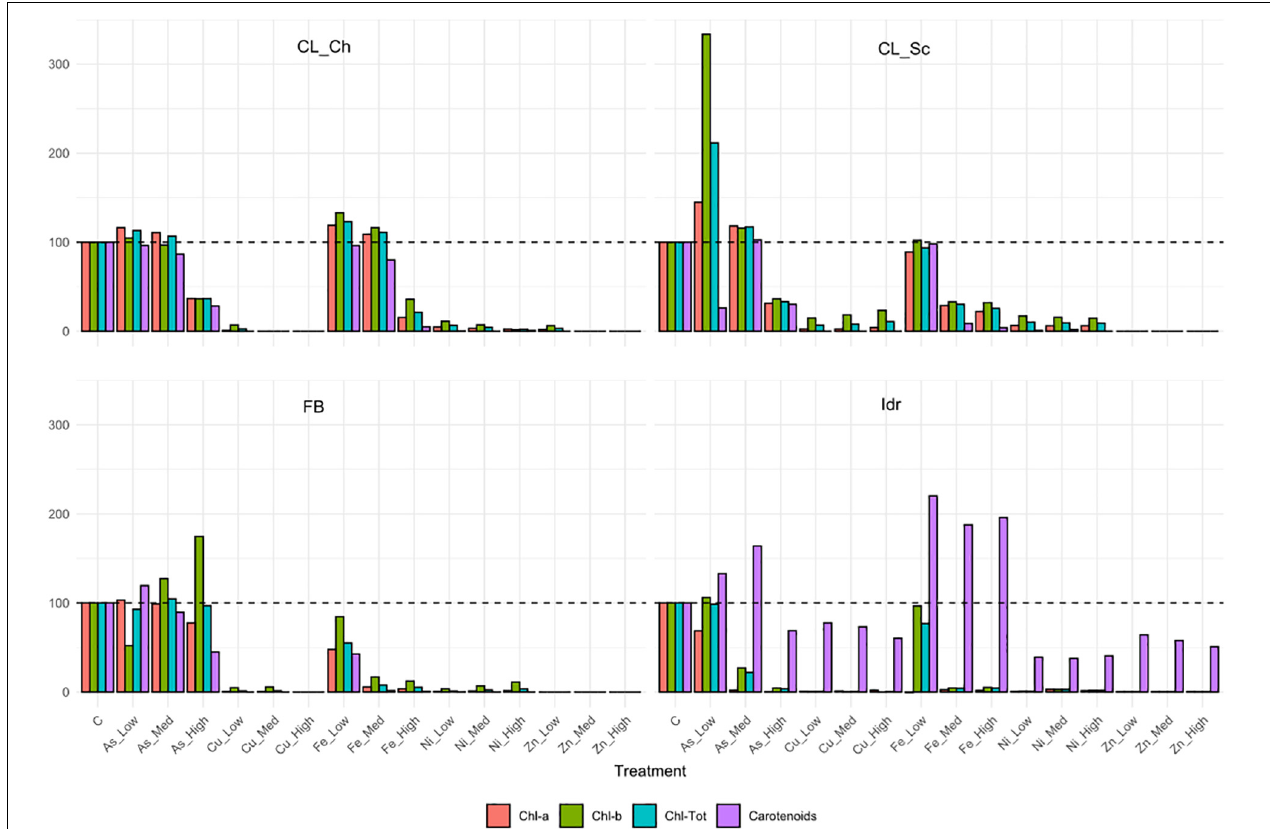
FIGURE 5 | Pigment contents related to the metal tolerance tests, expressed as % compared to the pigment content of control test (C) in the algal strains. The 100% pigment content of C is represented by the dashed line.